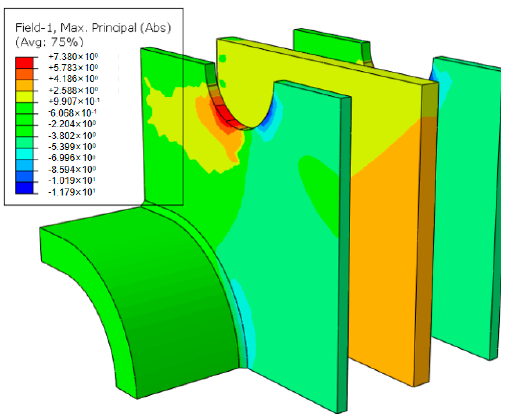
Figure 7. Maximum primary stress difference around R-plate and web weld between prototype and scale model.